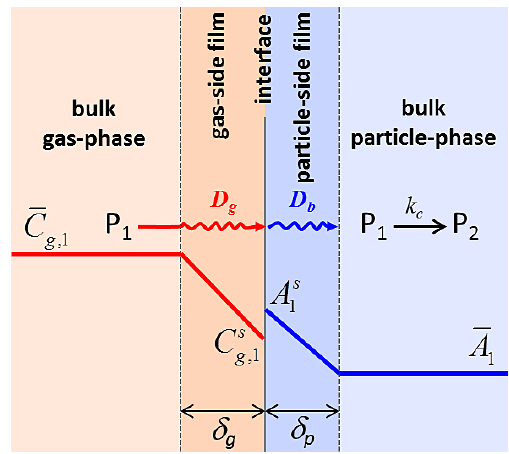
Figure 8. Schematic of the two-film